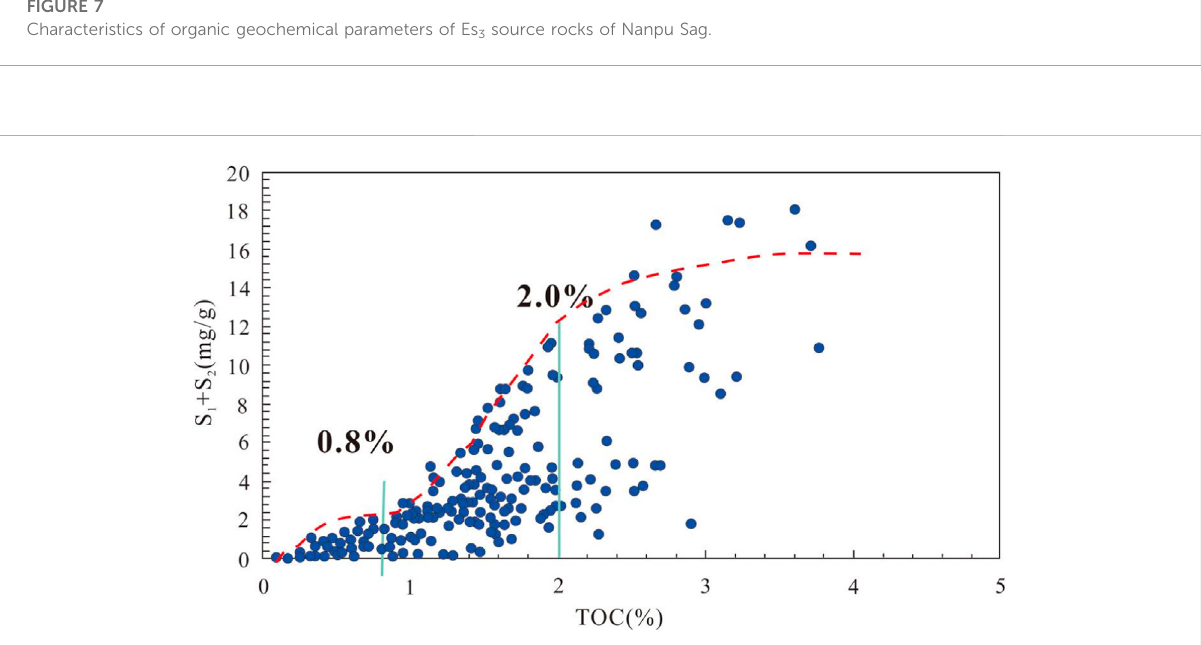
FIGURE 8 Relationship between S 1 + S 2 and TOC of Es 3 source rocks in Nanpu